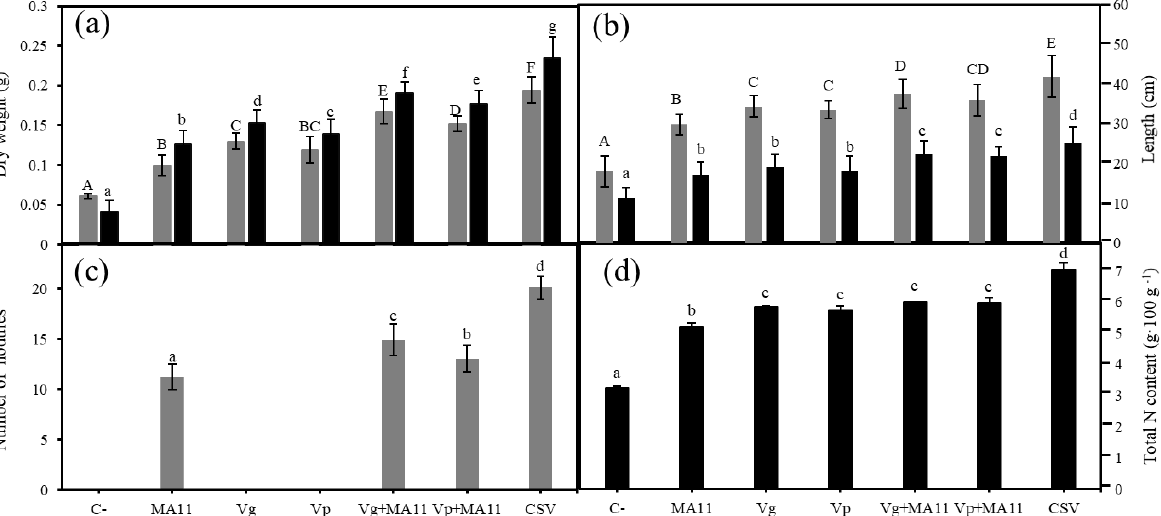
Figure 4. Effects of M. sativa inoculation with Variovorax in nutrient-poor soils. ( a ) Dry weight, ( b ) length, ( c ) number of nodules, and ( d ) nitrogen content in shoots of M. sativa plants after 60 days in pots with a nutrient-poor soil as a substrate under greenhouse conditions. Values are means ± S.D. ( n = 16). Different letters indicate means that are significantly different from each other (one-way ANOVA; LSD test, p < 0.0001). C–: non inoculation; MA11: inoculation with Ensifer medicae MA11; Vg: inoculation with Variovorax gossypii JM-310 T ; Vp: inoculation with V. paradoxus S110 T ; Vg + MA11: co-inoculation with V. gossypii JM-310 T and E. medicae MA11; Vp + MA11: co-inoculation with V. paradoxus S110 T and E. medicae MA11; CSV: inoculation with V. gossypii JM-310 T , V. paradoxus S110 T , and E. medicae